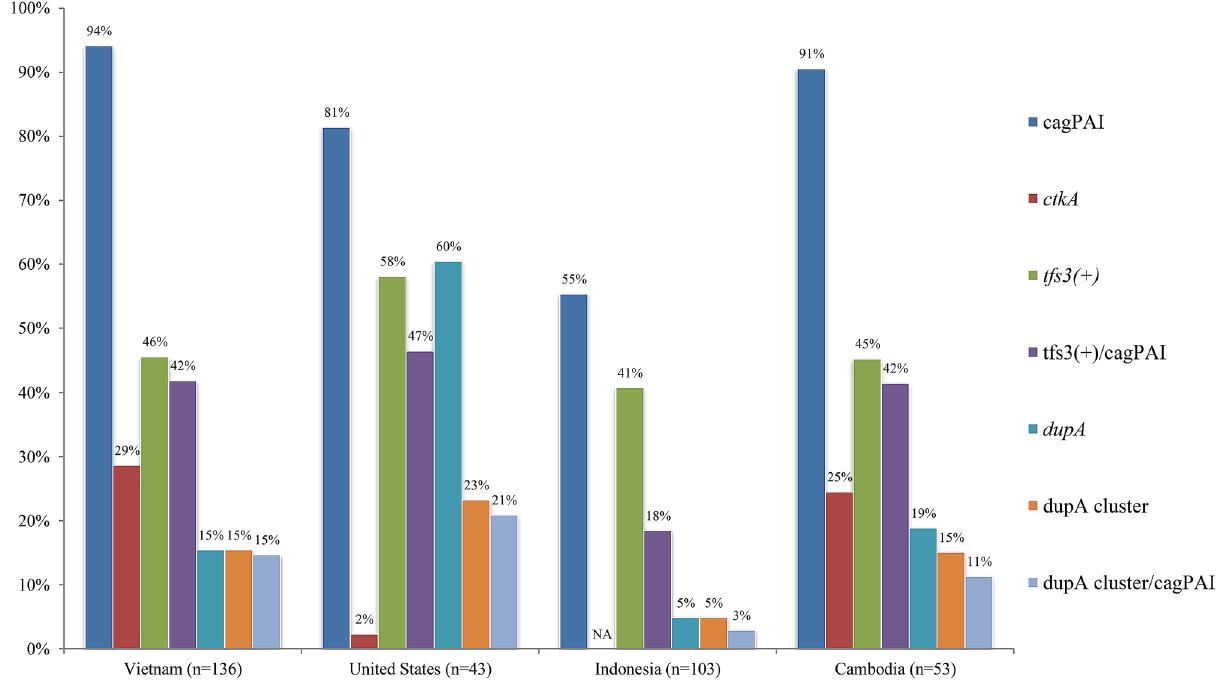
Figure 4. Distribution of tfs3 , dupA cluster, and cagPAI across four geographical regions: Vietnam, Indonesia, Cambodia, and the US (Bronx, NY). The prevalences of ctkA and dupA were included for the